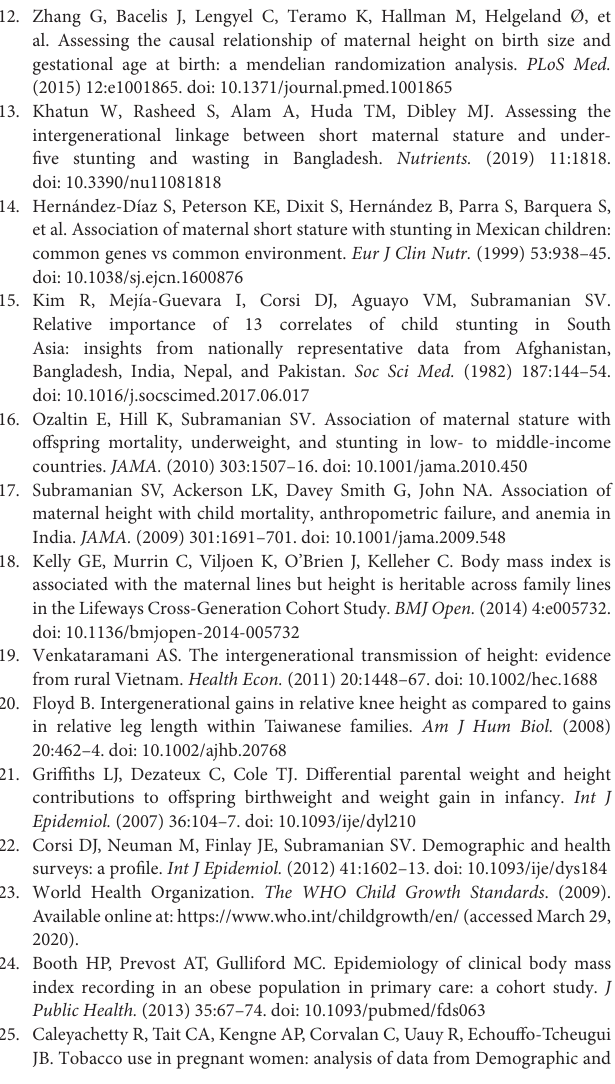
included for analysis by country. Supplementary Table 2 | Characteristics between the included and excluded participants by country. Supplementary Table 3 | The adjusted relative risk (RR) with 95% confidence intervals (CIs) is based on each combination of maternal and paternal height quintile. Supplementary Table 4 | Adjusted β between maternal and paternal height and child HAZ and RR between maternal and paternal height quintile and children stunting with their 95% CIs for sensitivity